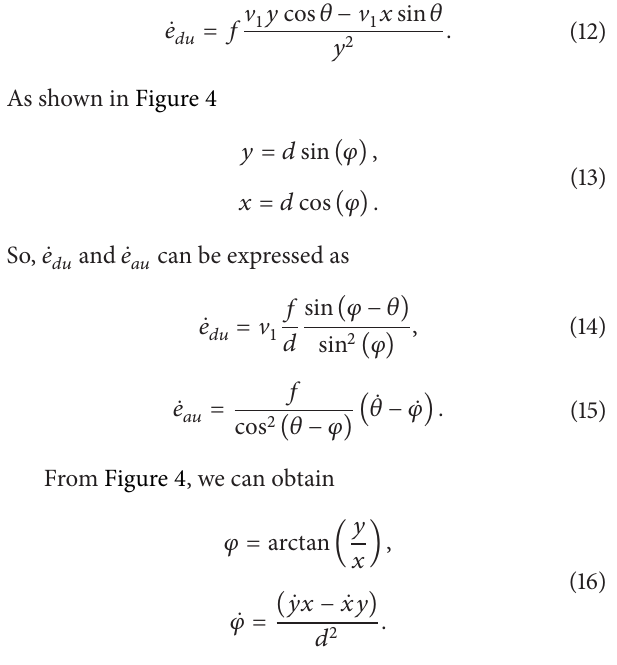
Figure 4: The geometry relation between current configuration and desired